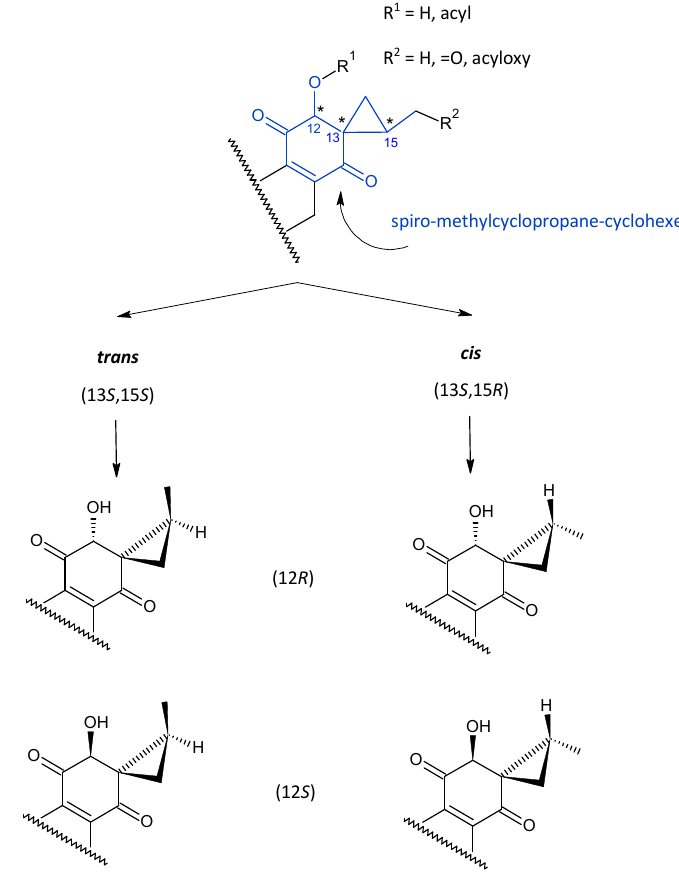
Figure 3. Spirocoleon skeleton and its stereochemistry [24,70].